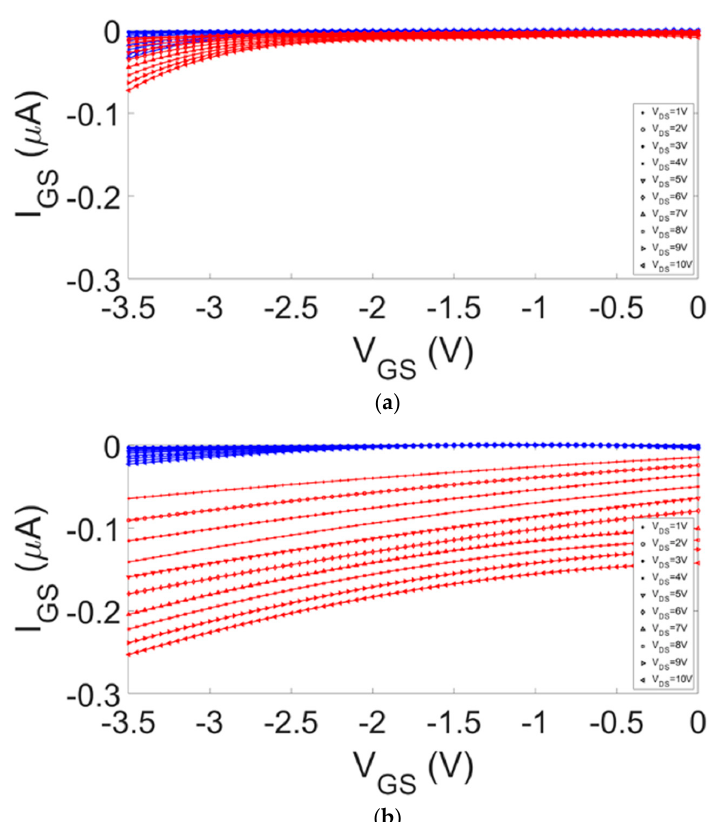
Figure 8. I GS versus V GS with V DS from 1 V to 10 V (step 1 V) measured for ( a ) the 100 μ m HEMT and ( b ) the 200 µm HEMT without (blue line) and with (red line) laser exposure.